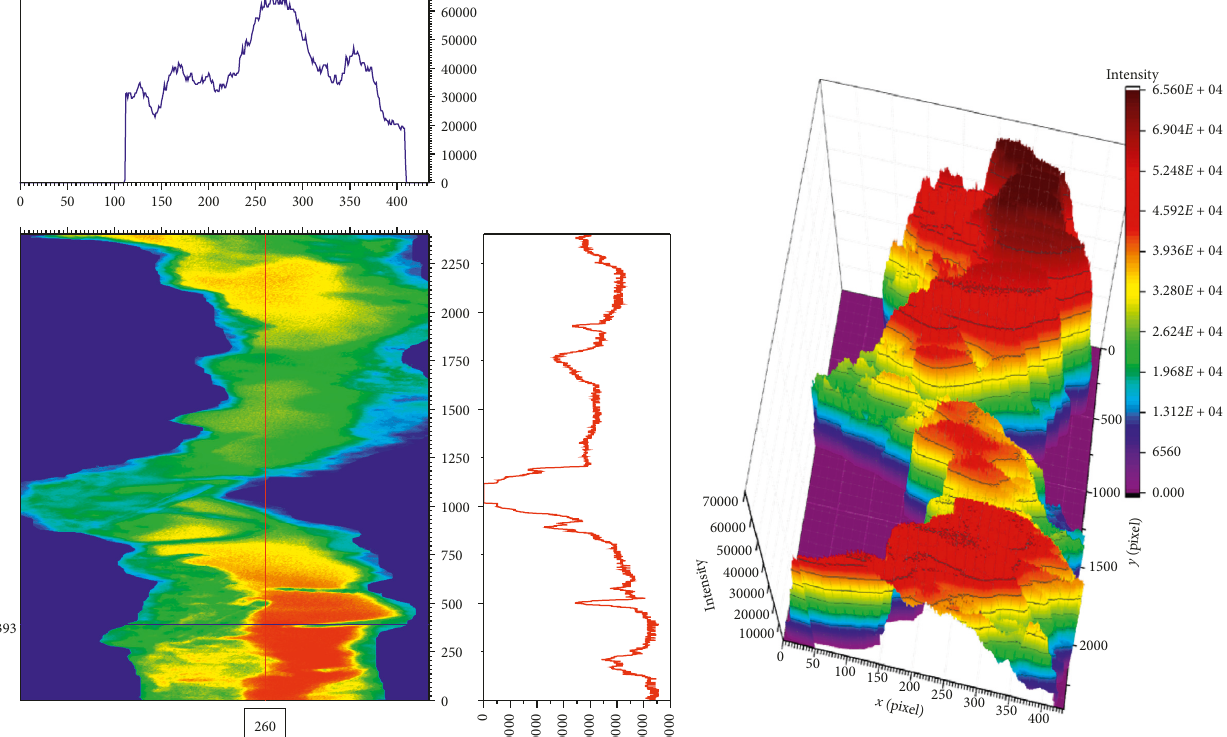
Figure 12: Pixel intensity distribution of 2D and 3D forms of the combined image in Figure